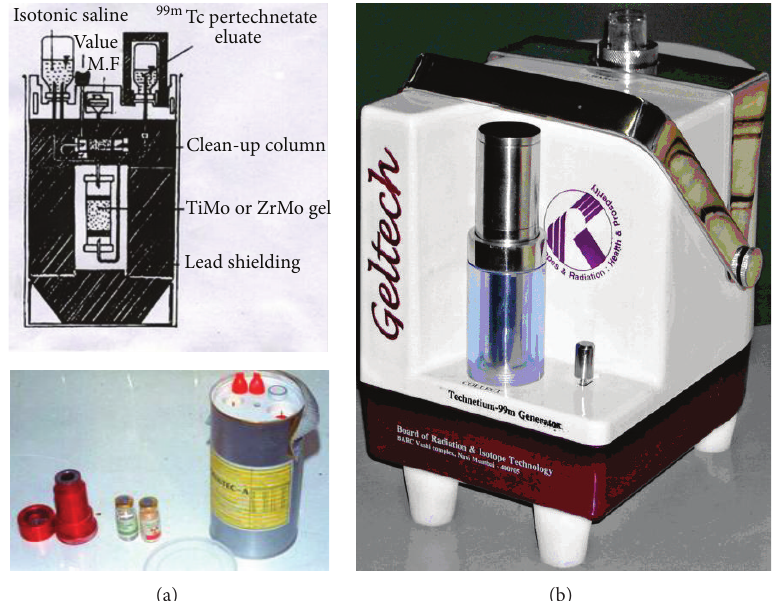
Figure 10: Typical chromatographic gel-type 99 m Tc generators (dual column systems compose of a ZrMo ( 99 Mo) gel column coupled with a purification acidic-alumina column): (a) Gelutec-A 99 m Tc-generator manufactured by NRI (Vietnam); (b) Geltech 99 m Tc-generator by BRIT (India). (Note: no 99 m Tc-concentration is available in these generator systems. In Gelutec-A system, two alumina columns are installed in parallel and a selector/valve is inserted between them to direct the 99 m Tc eluate from the gel column being passed over each column for 5 consecutive purification/elutions) [2, 57, 59, 60, 103].